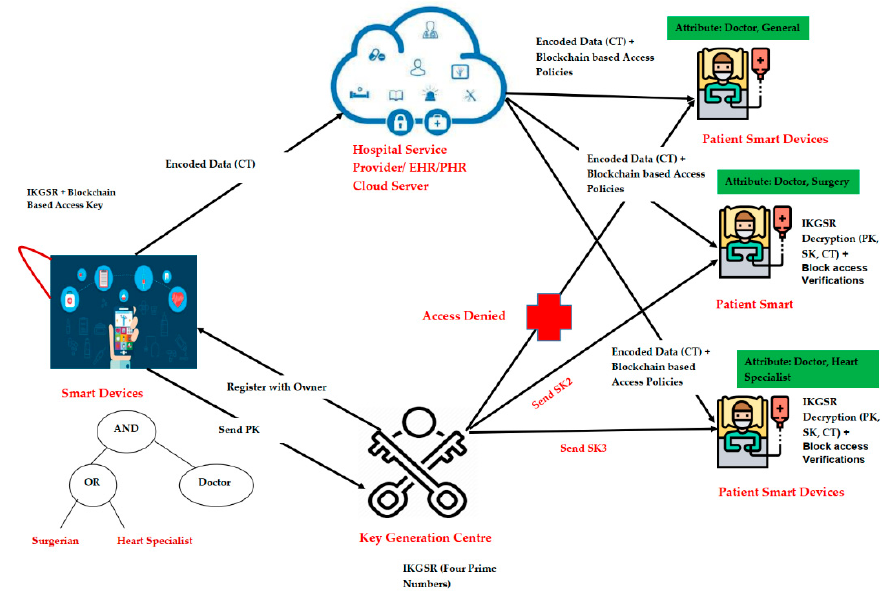
Figure 7. Application Scenario of the Proposed Method.